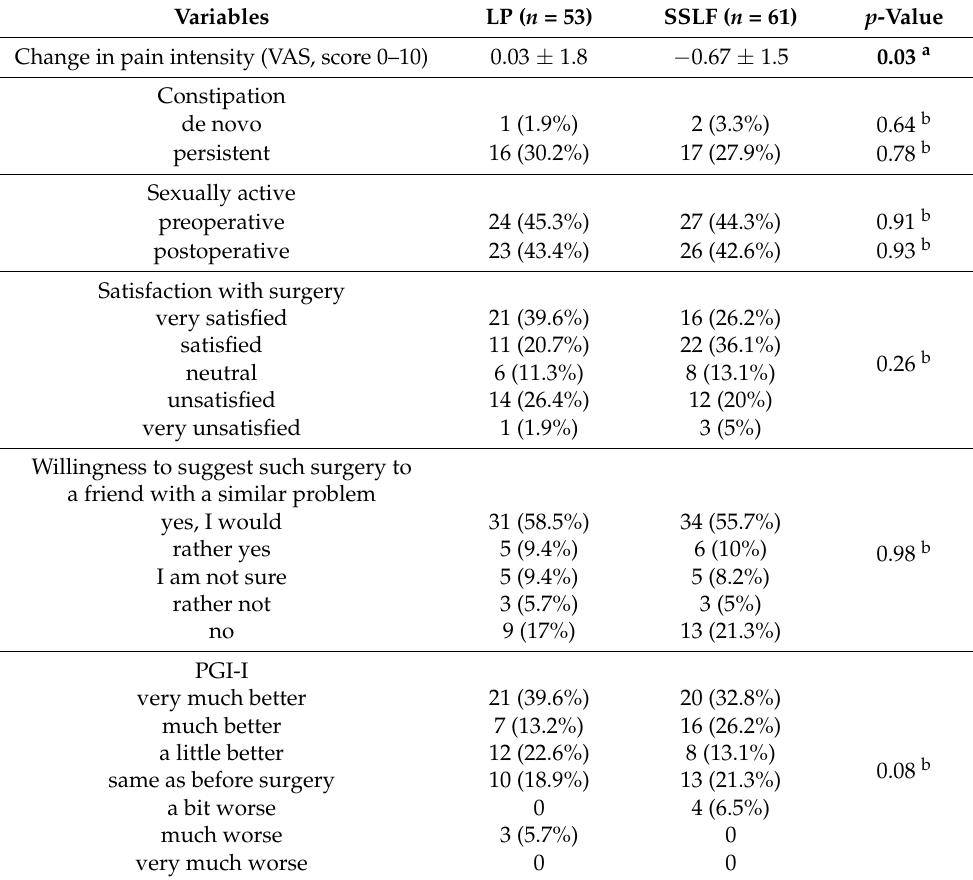
Table 5. Subjective outcomes—part